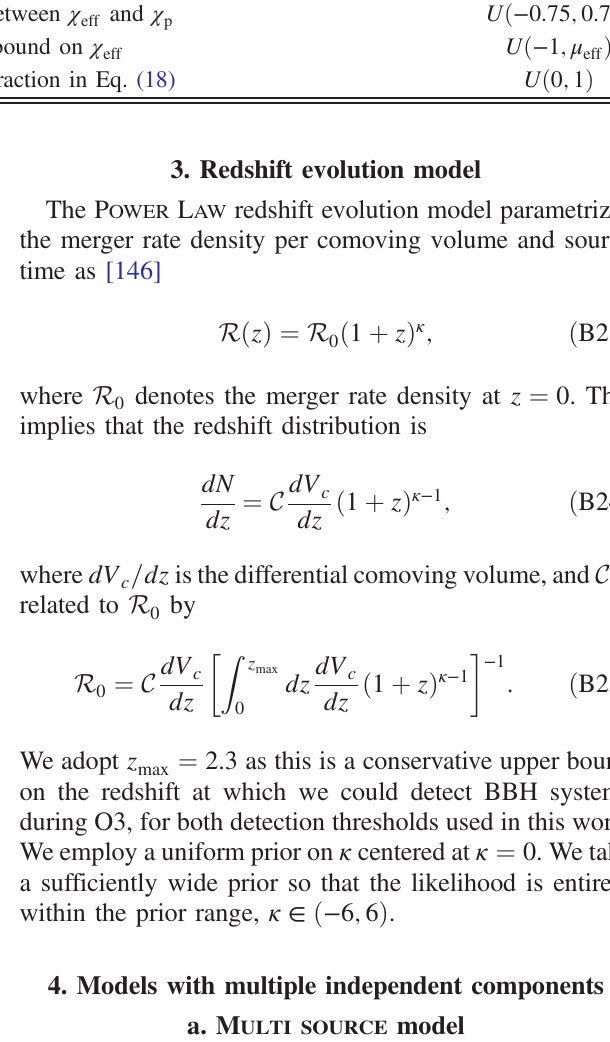
and ζ parameters appear only in variants of the G AUSSIAN model, as eff ; min